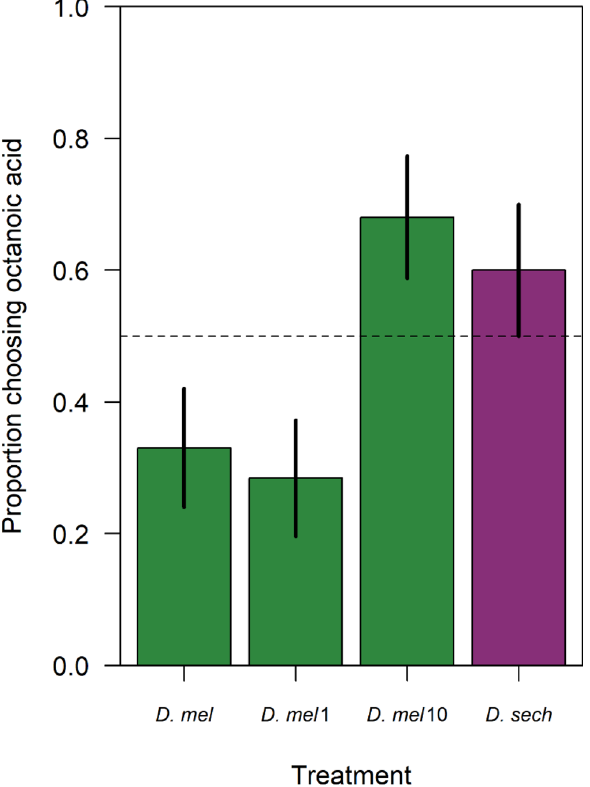
Figure 2. The proportion of flies that chose to disperse to fly medium containing octanoic acid versus regular fly food. The treatments include: D. melanogaster reared on regular fly food ( D. mel ), D. melanogaster reared on fly food supplemented with D. sechellia gut microbiota for one generation ( D. mel 1), D. melanogaster reared on fly food supplemented with D. sechellia gut microbiota for 10 generations ( D. mel 10) and D. sechellia ( D. sech ) reared on M. citrifolia . Sample means and 95% confidence intervals from 10,000 bootstrap simulations